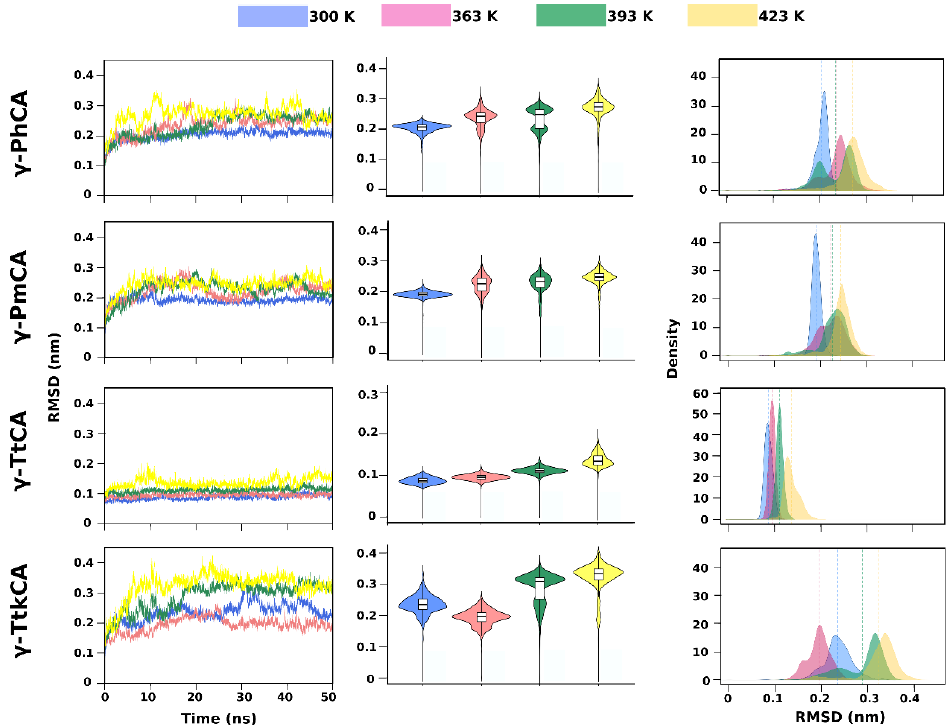
Figure 3. Root mean square deviation (RMSD) line graphs ( left ), violin plots ( middle ), and kernel density estimation (KDE) plots ( right ) of γ -PhCA, γ -PmCA, γ -TtCA and γ -TtkCA at 300 K, 363 K, 393 K and 423 K. Median values in the violin plots are shown by the black line in the white box plots and those in the KDE plots are shown as a line with a color corresponding to the respective plot color.